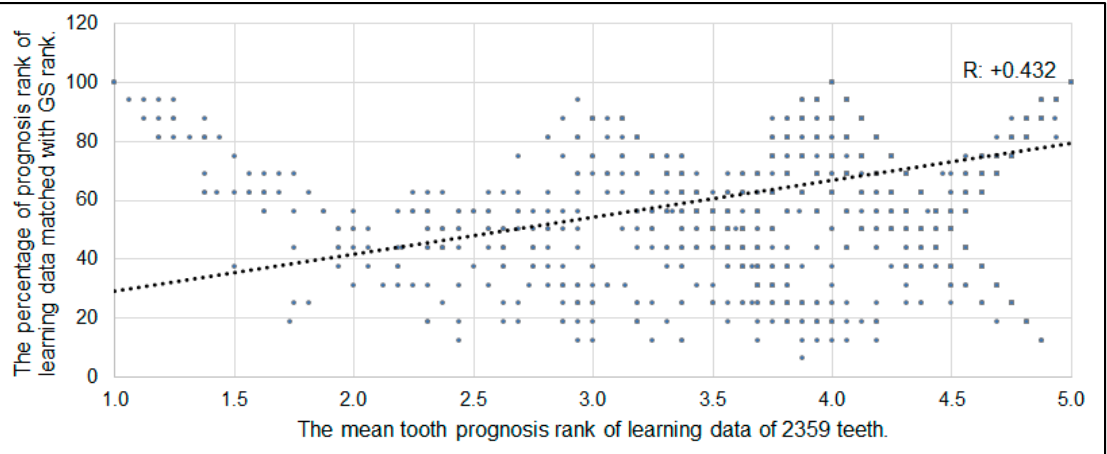
Figure 6. Association between diagnosis tooth rank and matching percentage with GS rank. The Pearson’s correlation indicated that there was a significant medium positive relationship ( p < 0.001) between the percentage of prognosis rank of learning data matched with GS rank and the mean tooth prognosis rank of learning data of 2359 teeth.